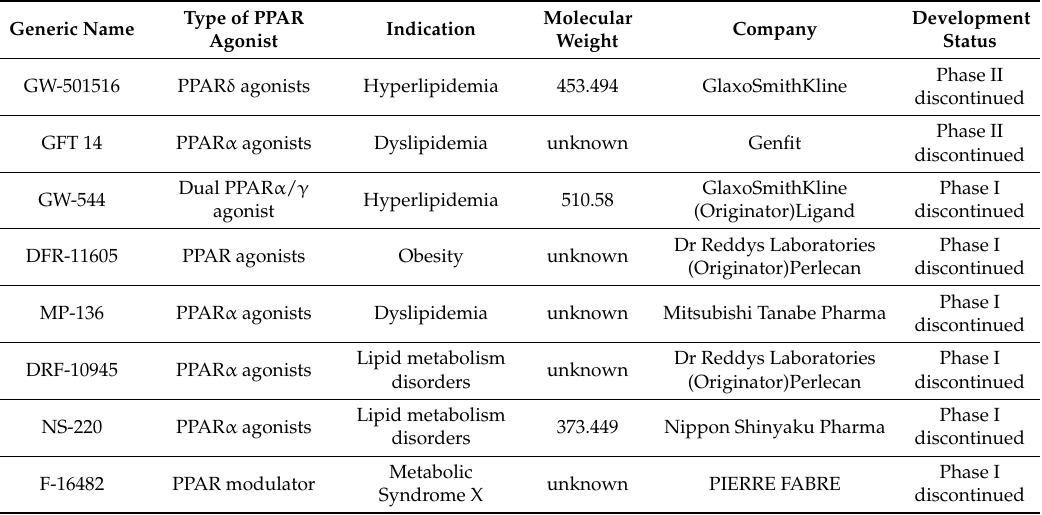
Table 10. Drugs of PPAR ligands for treatment of dyslipidemia discontinued in clinical stage.